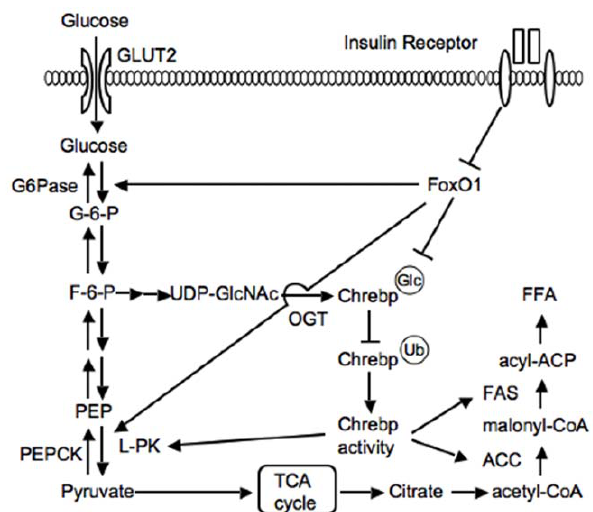
Figure 4. Proposed model for the role of FoxO1 integrating glucose utilization and lipid synthesis through regulation